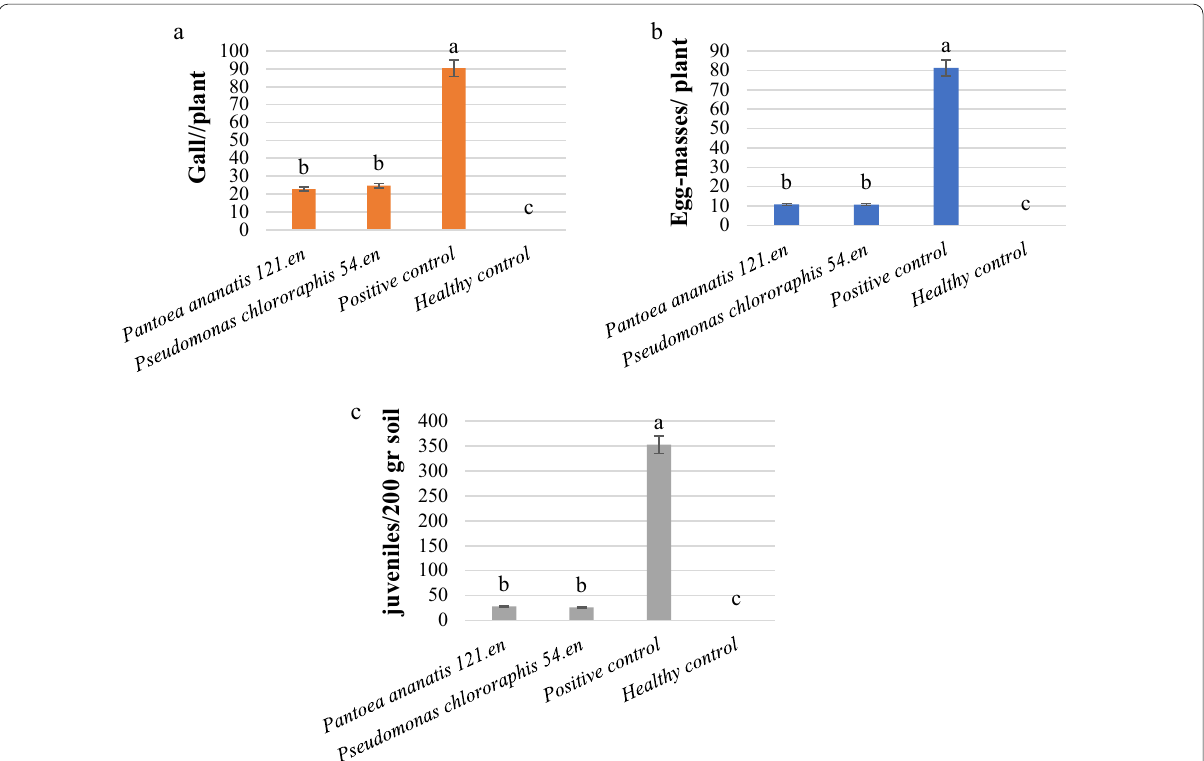
Fig. 4 Mean comparisons of nematode reproductive factors in treatments; a and b : The number of gall and egg masses in root system; c : The number of juveniles in 200 gr of soil. Positive control (nematode only) and negative control (without bacteria and nematode)